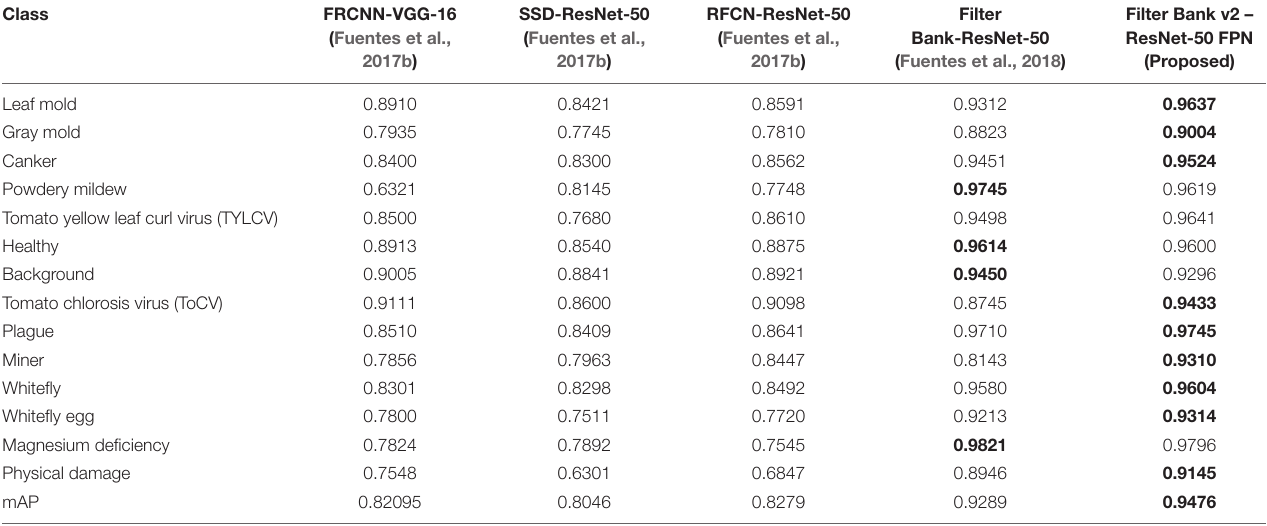
TABLE 3 | Performance of the bounding box detector (mAP).